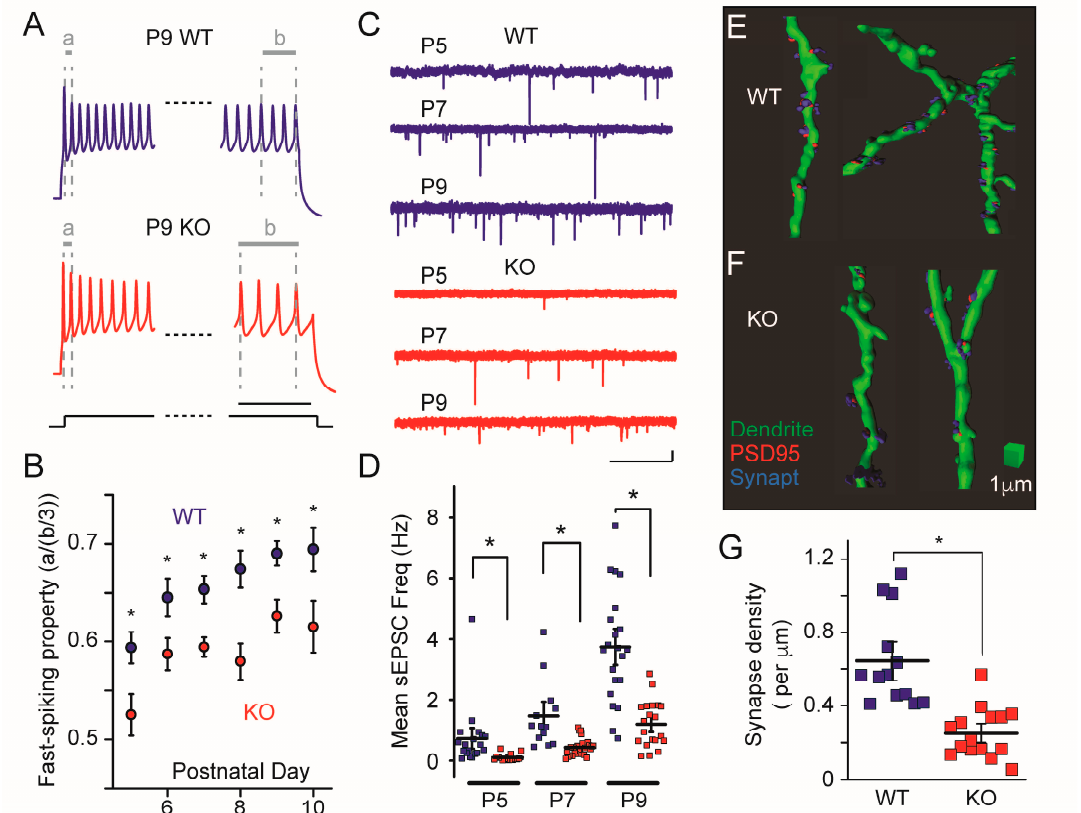
Figure 2. ( A ) Representative voltage response traces of PV interneurons in developing (postnatal day 9: P9) Fmr1 WT (top) and KO (bottom) mice. The initial and final portions of the 500-ms-long traces were magnified for clarity. Note the significantly greater ratio of the last three inter-spike intervals “b” to the first inter-spike interval “a” in KO mice compared to in WT mice, which indicates that PV interneurons equip less fast-spiking properties in KO mice. Calibration: 50 ms. ( B ) Collective data for fast-spiking property during the development (P5–P10) in Fmr1 WT and KO mice. The spiking property was quantified by “a” divided by “b/3”. * Denotes p < 0.05. ( C ) Representative sEPSC traces recorded from developing (P5–P9) PV interneurons in Fmr1 WT (top) and KO (bottom) mice. Calibration: 1 s and 10 pA. ( D ) Collective data for sEPSC frequency. Each data point represents the mean sEPSC frequency in each cell. The frequency increases developmentally but remains lower in Fmr1 KO mice. ( E , F ). Three-dimensional renderings of dendritic segments (green) of PV interneurons in Fmr1 WT ( E ) and KO ( F ) mice. Synapses are labeled with the colocalized puncta of postsynaptic marker PSD95 (red) and presynaptic marker synaptophysin (“Synapt”: blue). The reference cube represents 1- µ m calibrations. ( G ) Collective data for the analysis of the synapse densities in Fmr1 WT and KO mice (P9–P10). The density of the synapses was significantly lower in Fmr1 KO mice (from Reference [81] with